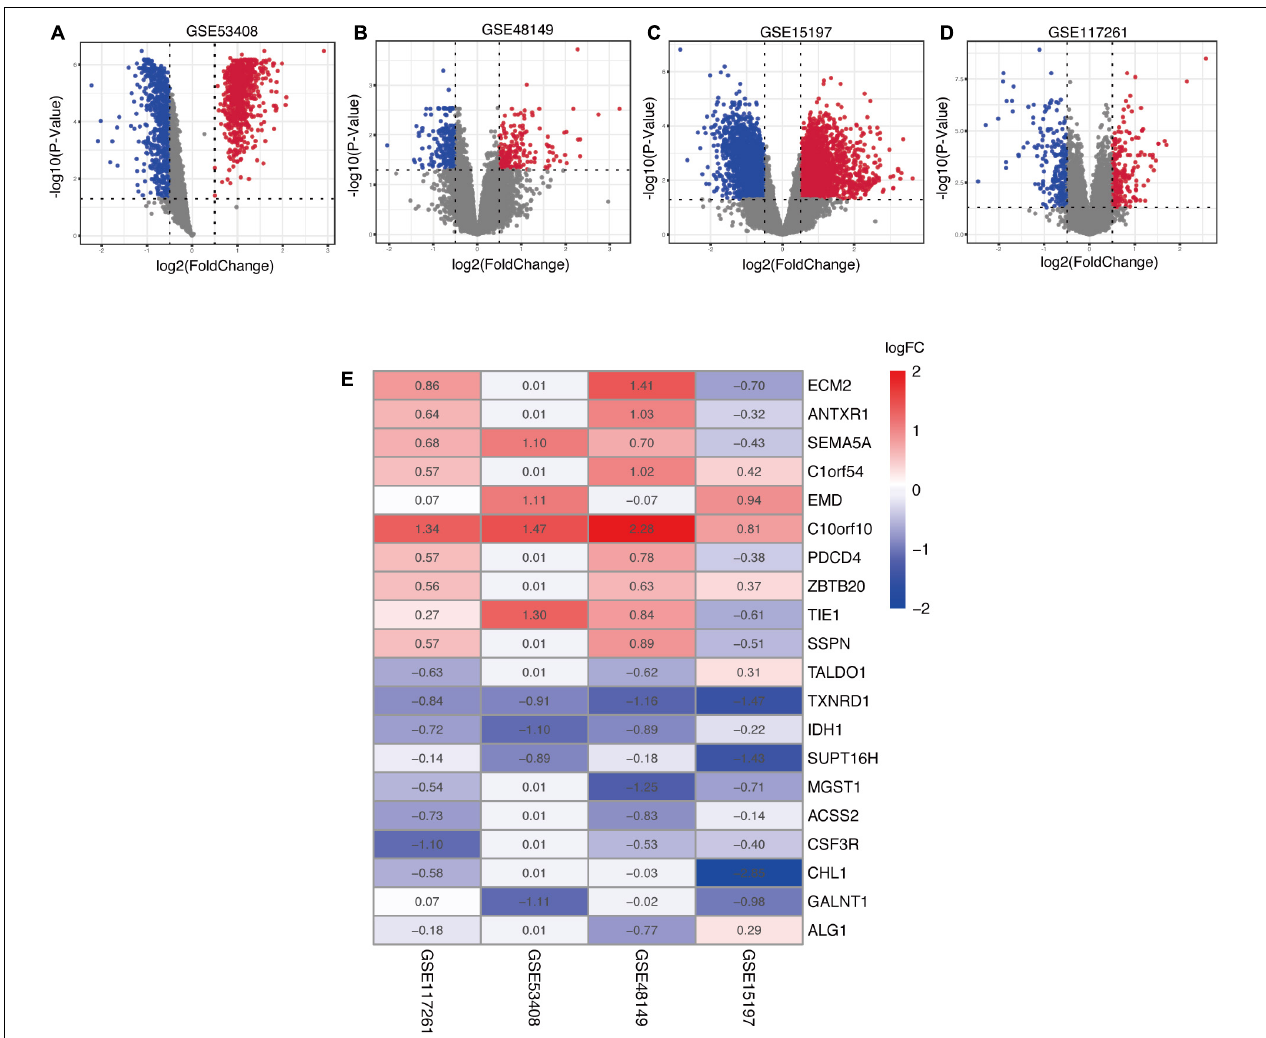
FIGURE 2 | Identification of robust DEGs among each GEO dataset. (A–D) The volcano plots of the distribution of DEGs in each dataset. (E) The heatmap of robust DEGs in the RRA analysis. The values in a cell represent |log2 fold-change (FC)| of each gene in a dataset. DEG, differentially expressed gene; GEO, Gene Expression Omnibus; RRA, robust rank